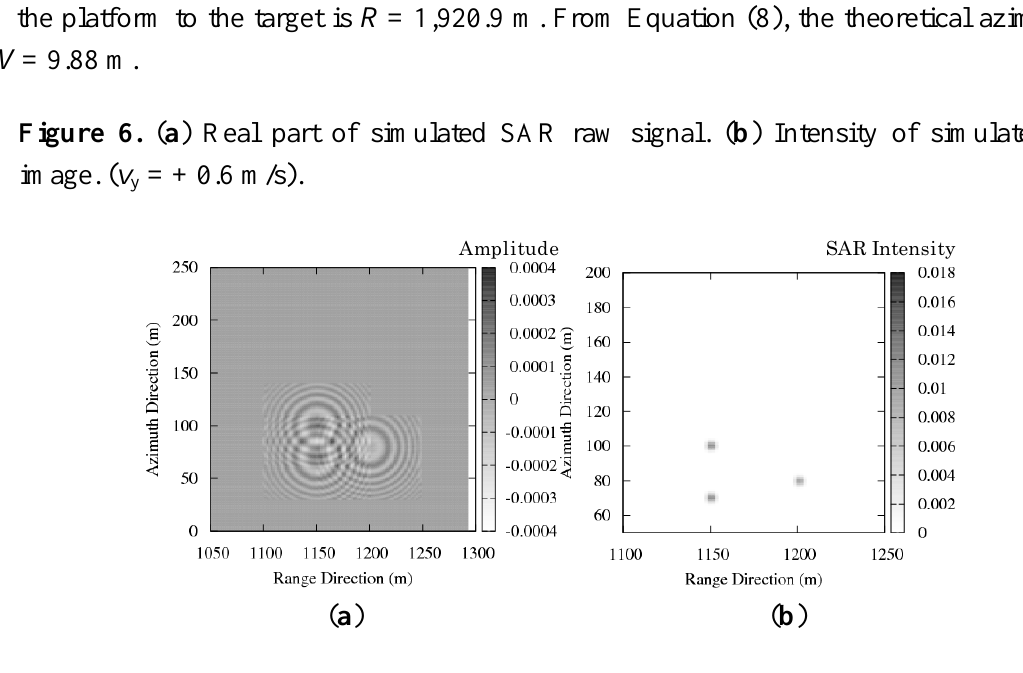
Figure 7. ( a ) Real part of simulated SAR raw signal. ( b ) Intensity of simulated SAR image. ( v = −0.6 y